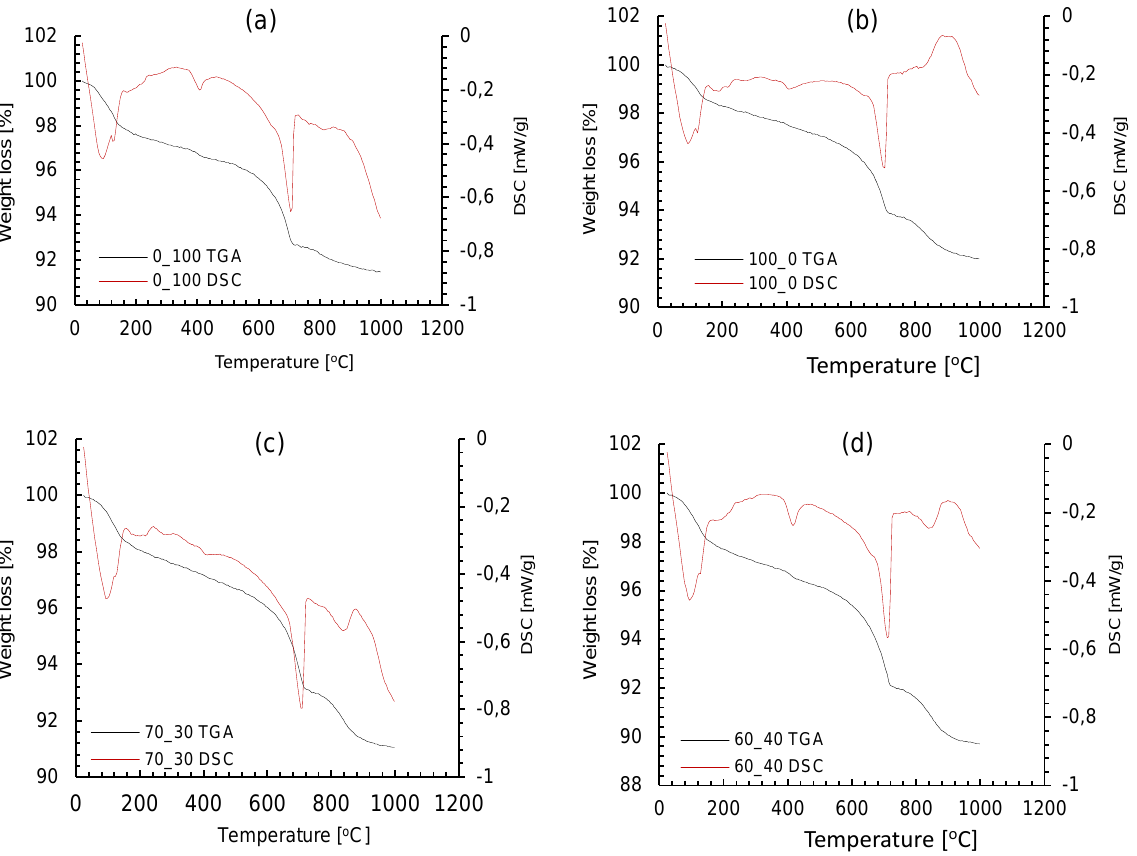
Figure 3: Typical thermogravimetric analysis and differential scanning calorimetry of one hour hydrated cement pastes with different proportions of natural gypsum and hemihydrate within the gypsum phase set at 4%. (a): Cement with hemihydrate 0/100; (b): cement with natural gypsum 100/0; (c): cement with 70/30 proportion; (d): cement with 60/40 proportion.